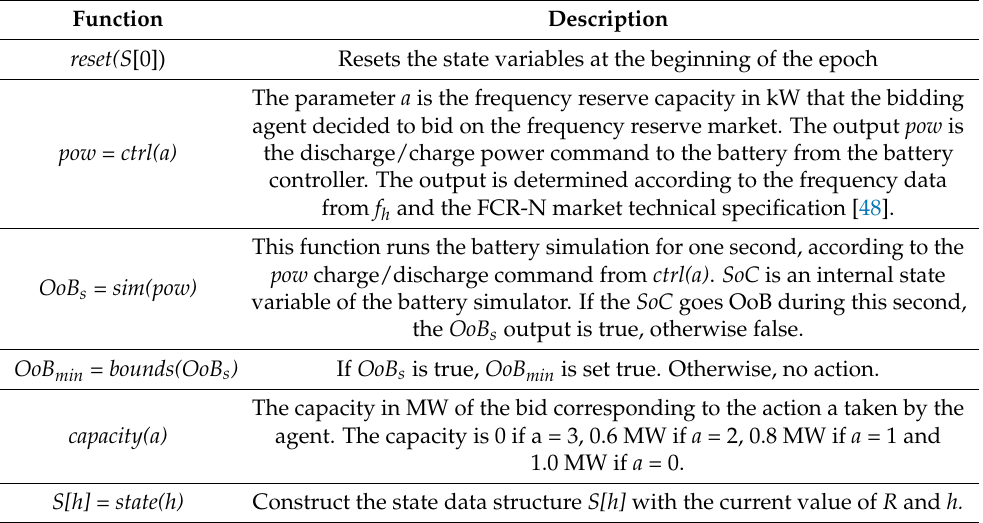
Table 2. Functions used in the procedure for training the reinforcement learning agent (Figure